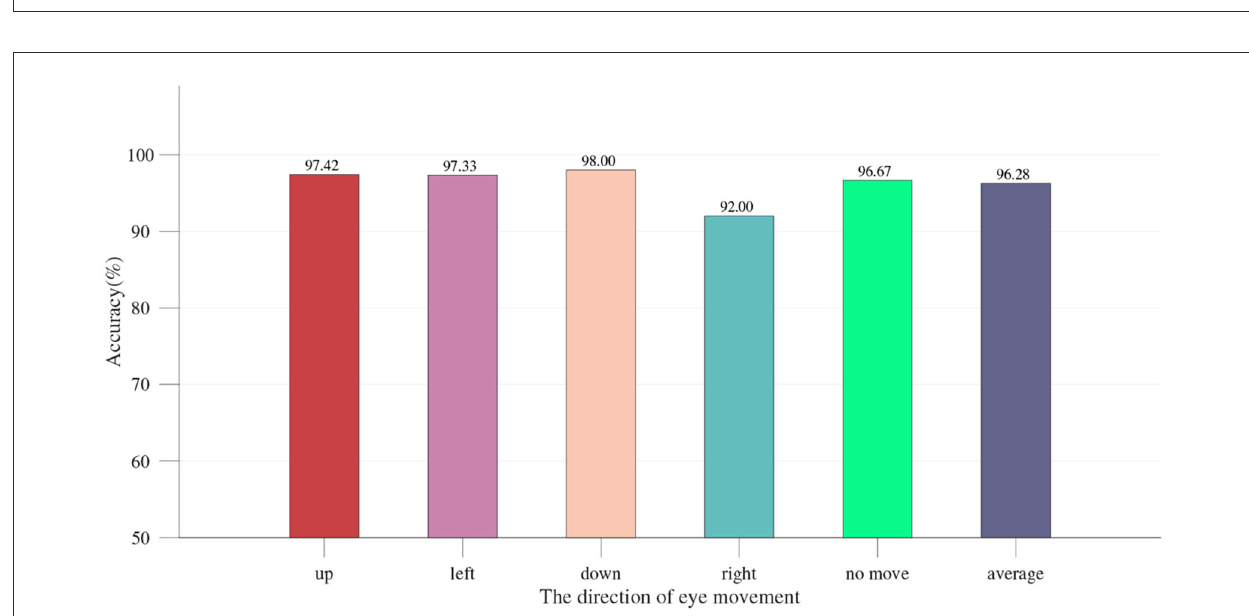
FIGURE8 Eye movement classification accuracy of dual-lead channel EOG electrodes.